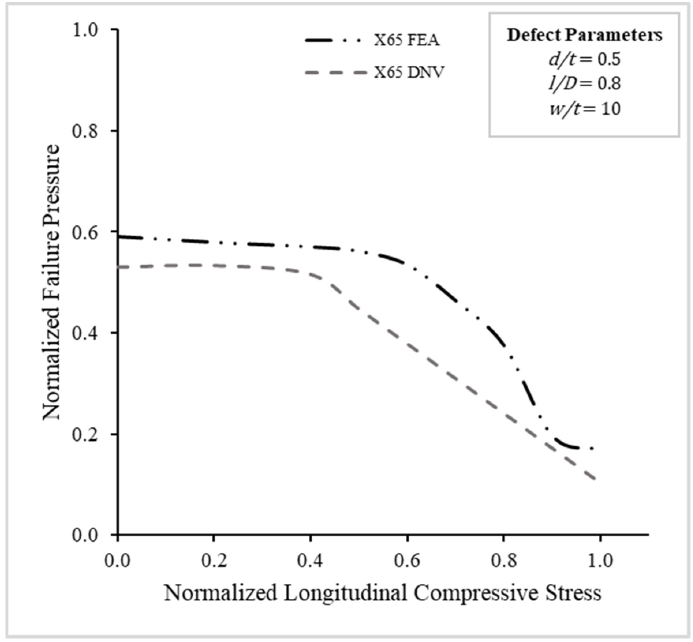
Figure 9. FEA and DNV predictions of normalized failure pressure predictions versus normalized longitudinal compressive stress.